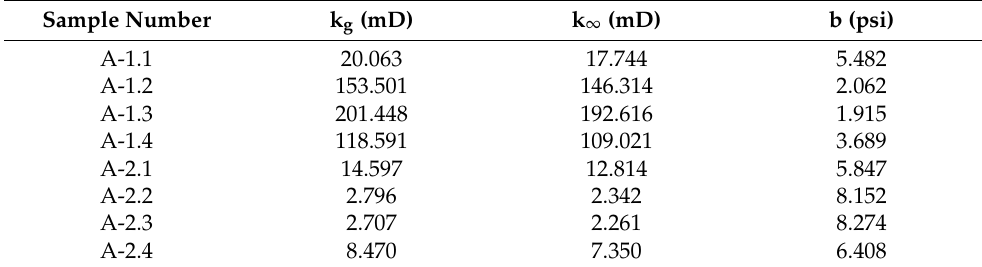
Table 3. Porosity and Klinkenberg-corrected permeability results of PETRONS-1 and PETRONS-2 core